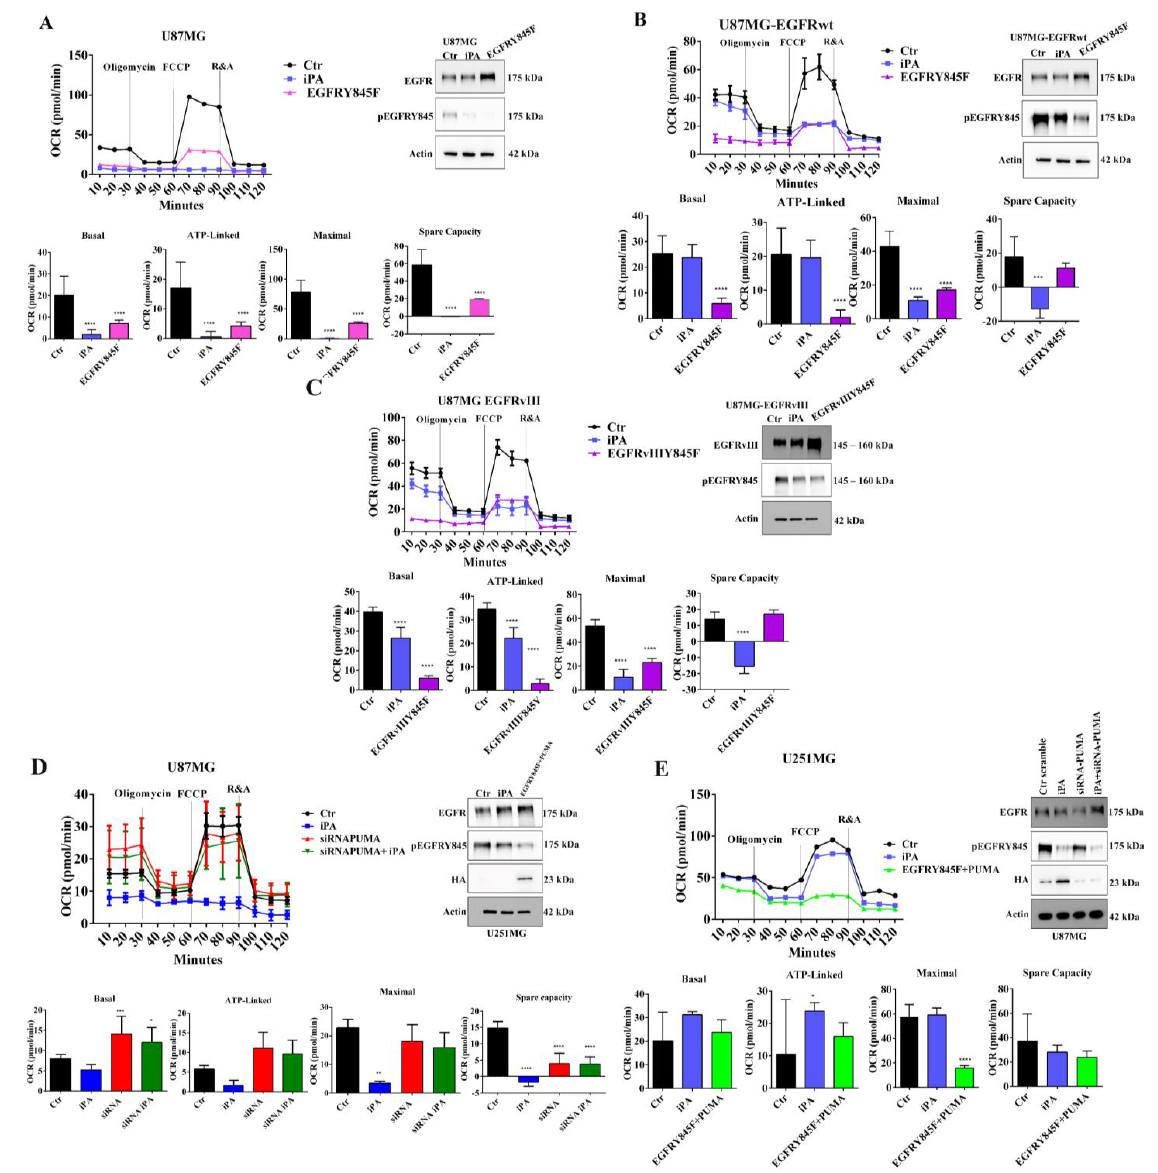
Figure 5. The Y845 phosphorylation of EGFR is important for mitochondrial activity. ( A – C ) Left : OCR schemes of U87MG, U87MG–EGFRwt, and U87MG-EGFRvIII treated with or without 10 µ M iPA and the same cells transfected with EGFRY845F. Right : western blot analysis showing protein levels of EGFR and pEGFRY845 in U87MG, U87MG-EGFRwt, and U87MG-EGFRvIII cells transfected with EGFRY845F. ( D ) Left : OCR in U251MG treated or untreated with 10 µ M iPA and the same cells transfected with EGFR Y845F + PUMA compared to the cells transfected with control vector. Right : western blot analysis showing protein levels of EGFR in U251MG cell lines transfected with EGFRY845F + PUMA compared to the cells transfected with control vector. ( E ) Left : OCR of U87MG treated or not with 10 µ M iPA and the same cells transfected with PUMA siRNA. Right : western blot analysis showing protein levels of EGFR, pEGFRY845, and PUMA in U87MG lines transfected with PUMA siRNA. Data are from three independent experiments in technical replicate. Data are expressed as mean ± SEM. Data were analyzed for statistical significance using the 2-tailed Student t -test or ANOVA followed by Bonferroni correction for multiple comparisons. Results are representative of 3 experiments performed in duplicate and are expressed as mean ± SD (ANOVA * p < 0.05; ** p <